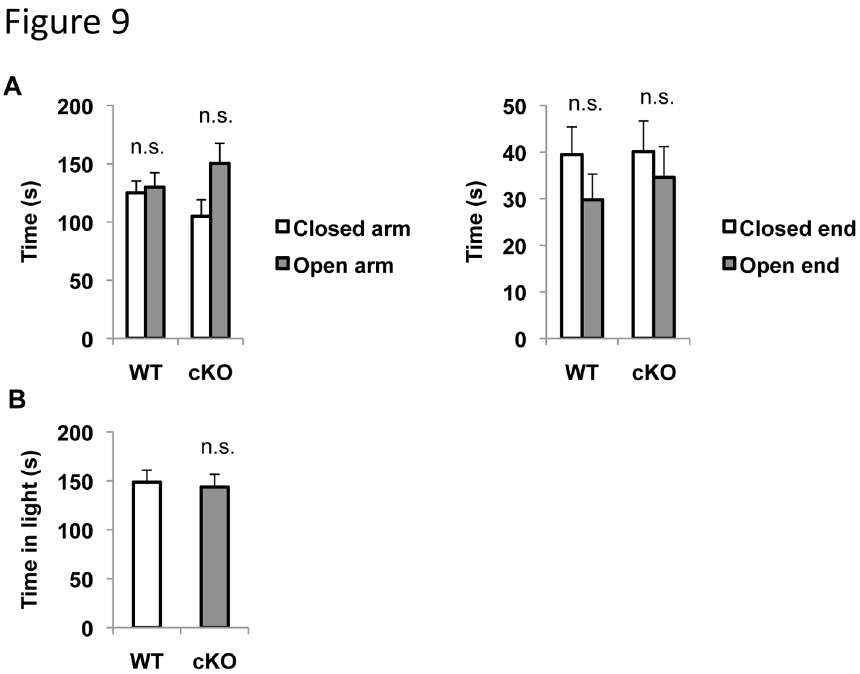
Figure 9. ERK5 deletion does not increase anxiety. A , ERK5 cKO mice do not show a preference for the closed arms or ends in the elevated plus maze assay, a characteristic feature of elevated anxiety. The distal one-third of the open and closed arms were defined as the open and closed ends respectively. B , ERK5 cKO and WT male mice spent an equal amount of time investigating in the light chamber of the dark/light box s., not significant.